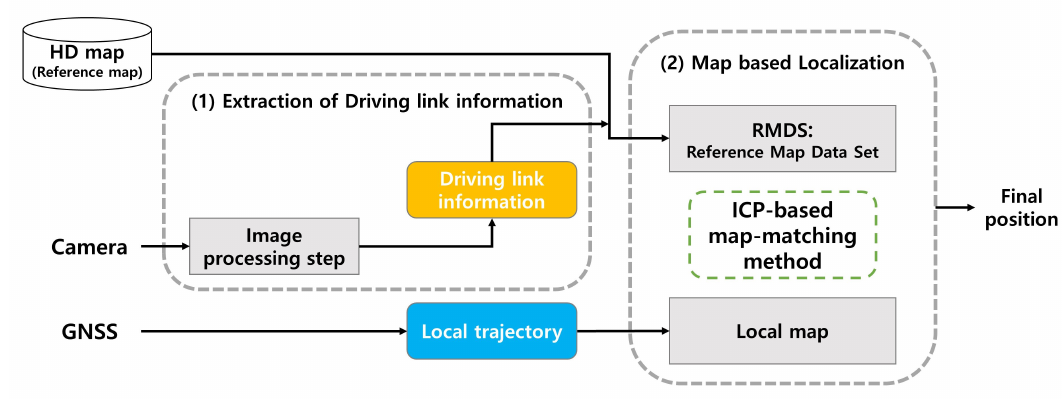
Figure 1. Framework of the proposed